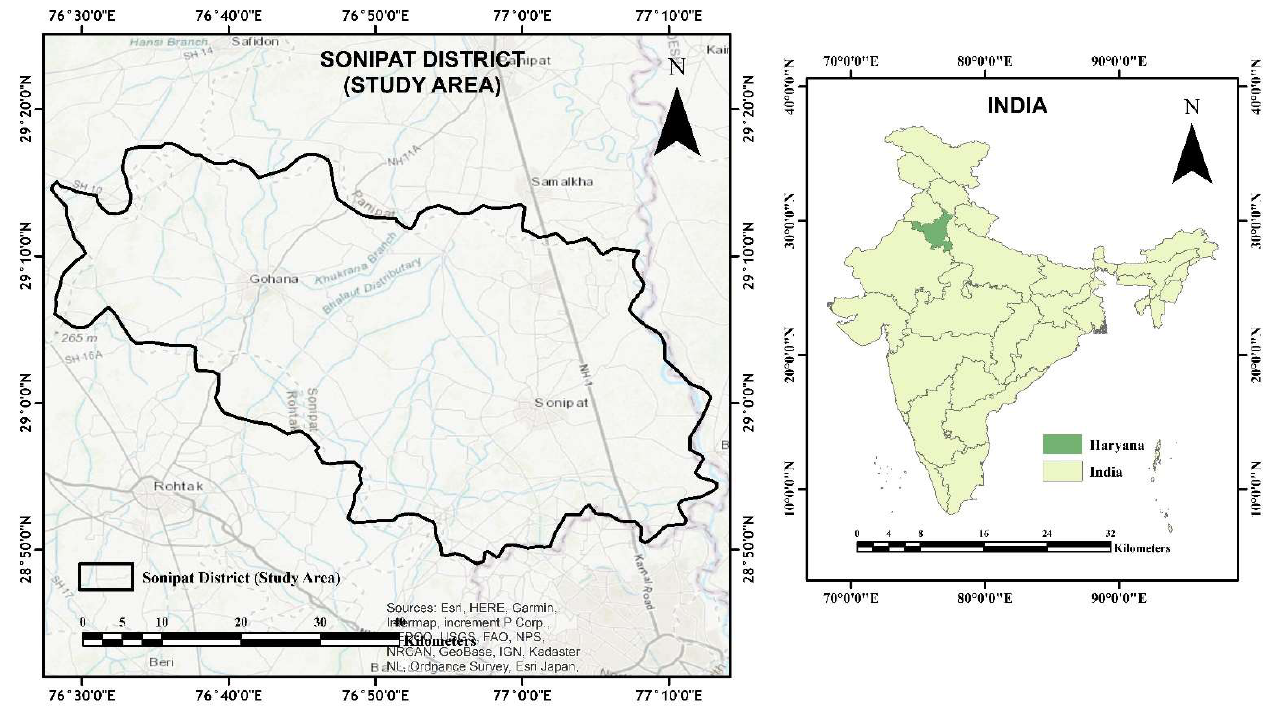
Figure 1. The geographic location of the area of study.